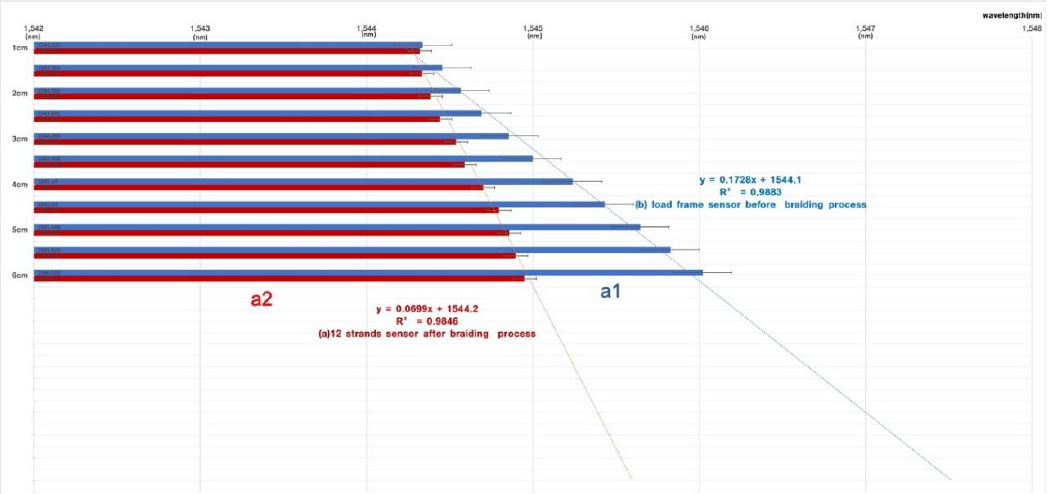
Figure 9. The result of Figure 6. The reliability value of each experiment is presented by the reliability constant for each result value. The stress–strain response change before and after braiding. ( a1 ) The wavelength shift for 1 cm displacement before braiding. ( a2 ) The wavelength shift for the unit (1 cm) displacement after braiding.